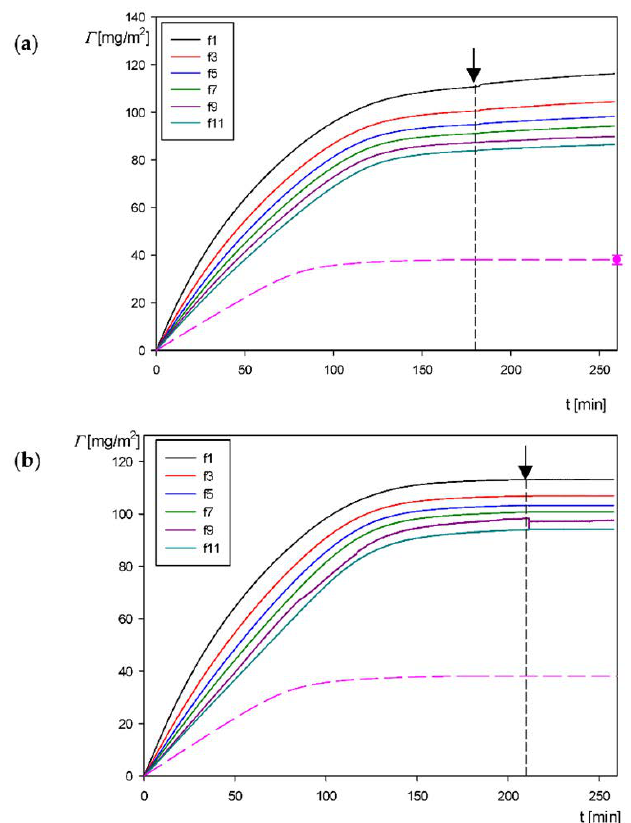
Figure 10. ( a ) Kinetics of the polymer particle deposition on the gold sensor derived from quartz microbalance (QCM) measurements: the corona coverage 0.80 mg m − 2 , pH 4, 10 mM NaCl, rived from the Sauerbrey model for various overtones, the dashed lines show the results predicted using the RSA model and the point shows the dry particle coverage derived from AFM. ( b ) Reference kinetic results for the positively charged amidine particle deposition on the gold sensor derived from lines show the experimental data derived from the Sauerbrey model for various overtones and the dashed lines show the results predicted using the RSA